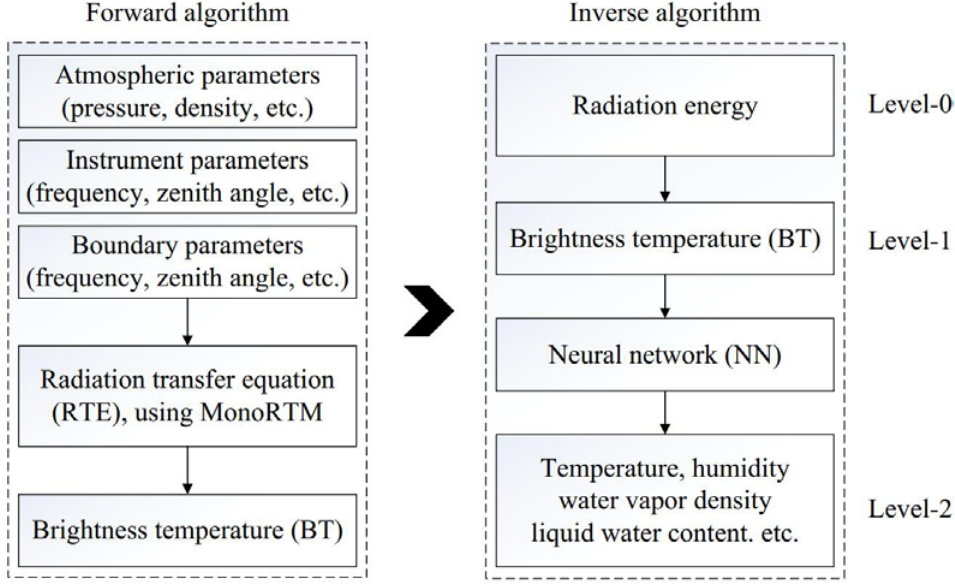
Figure 2. Forward and inversion algorithms.